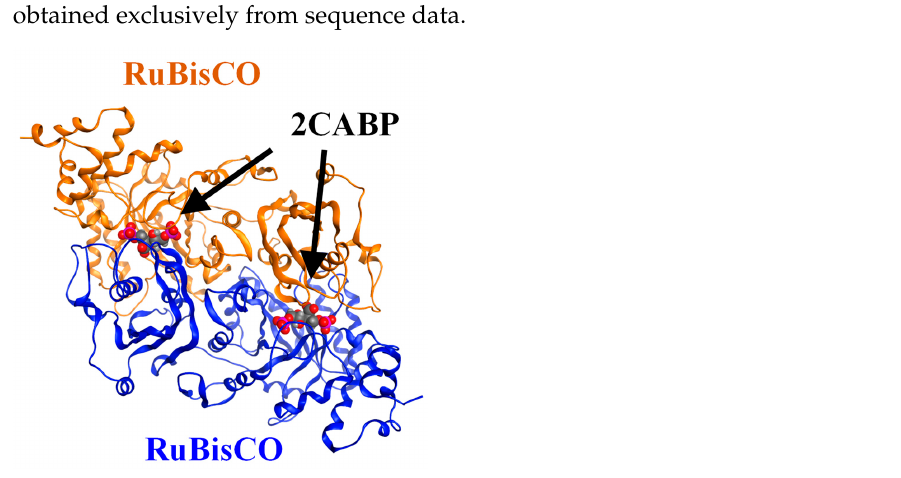
Figure 2. Crystal structure of RuBisCO complexed with a 2CABP ligand (Form II, PDB-ID: 4LF1). Ribbons (blue and brown) represent the L 2 dimer, and red spheres represent 2CABP. 2CABP, 2 ′ - carboxylarabinitol 1,5-bisphosphate; PDB, Protein Data Bank.